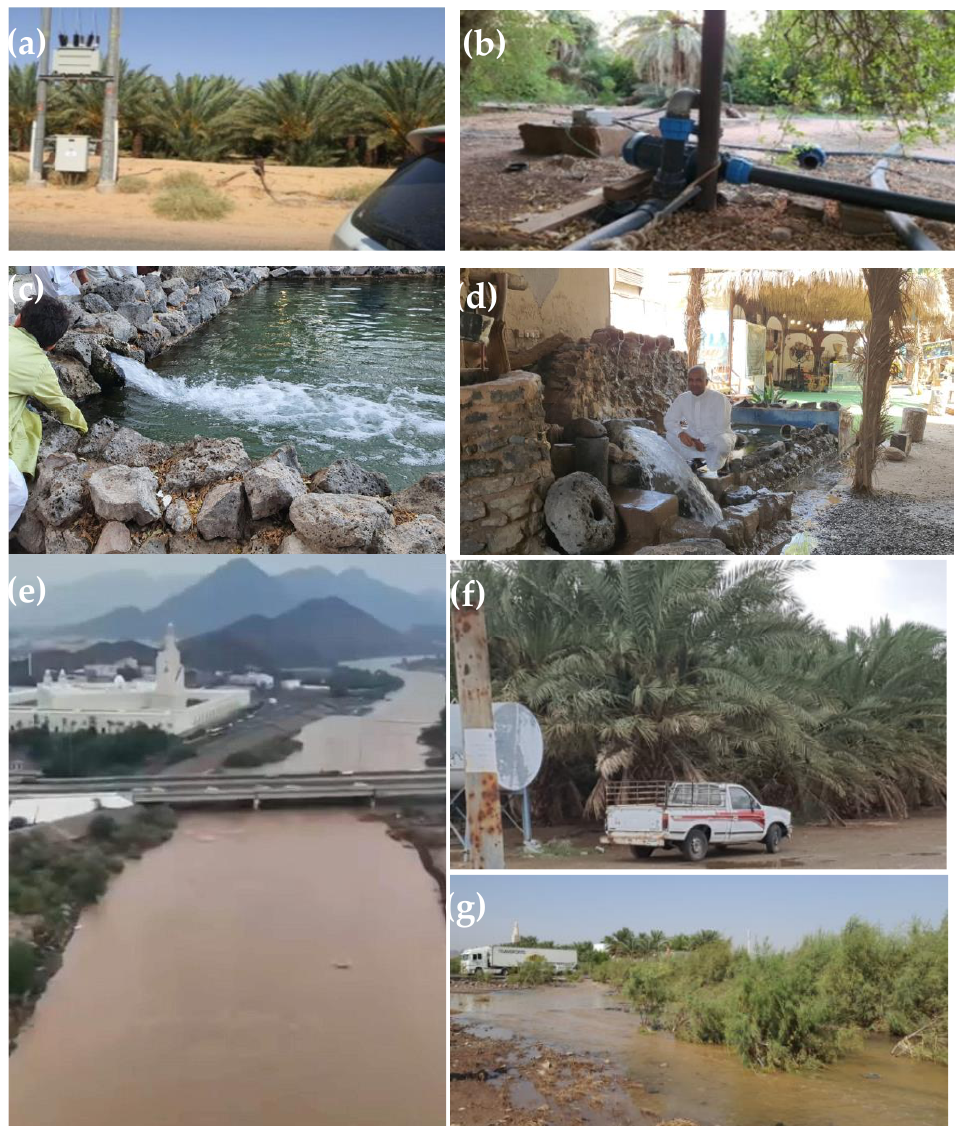
Figure 10. Field observations ( a ) Madaen Saleh; ( b ) Al Ula area displays the pumping well and vegetated area; ( c – e ) water wells at Al Madinah; ( f ) Al Yutamah area that is enriched in date palm trees; ( g ) Wadi Aqiq surface water flow during rainy storms.